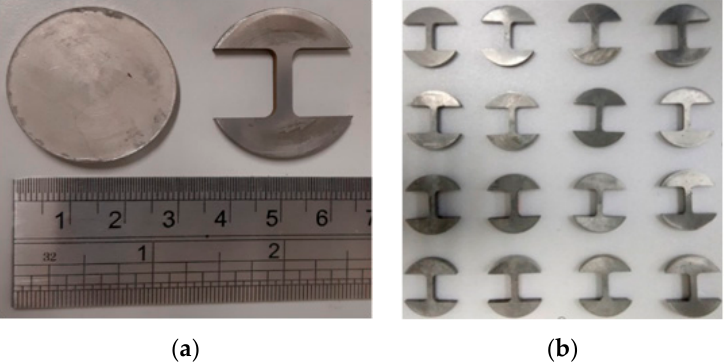
Figure 3. EDM machined samples for tensile testing ( a ) original sample before cutting ( b ) ready samples for tensile testing.